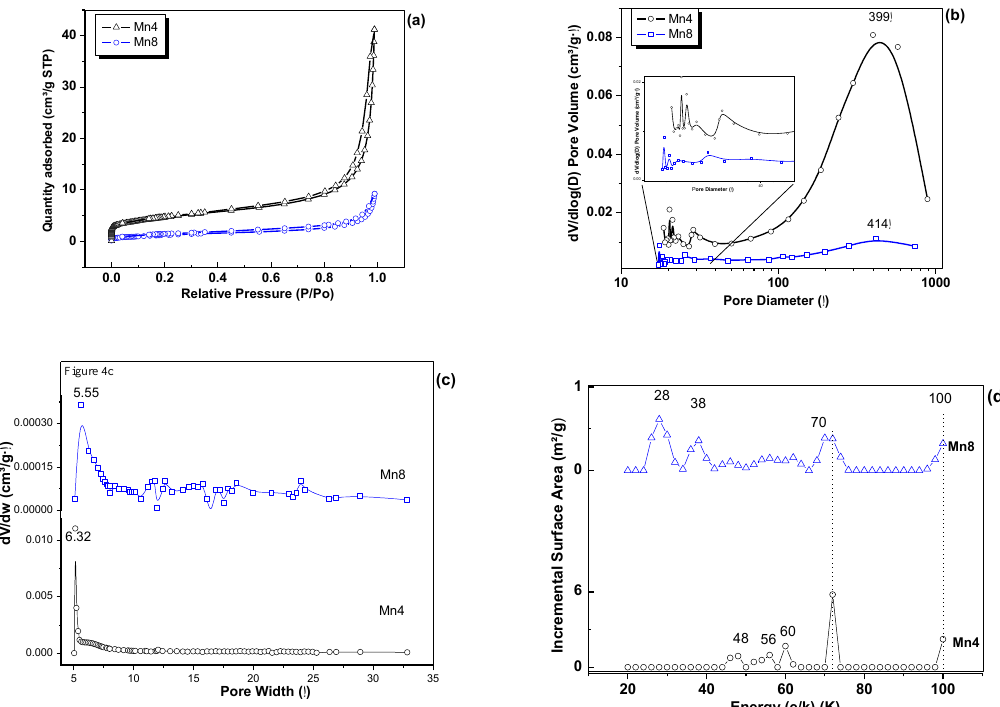
Figure 4. N 2 adsorption–desorption results: ( a ) N 2 isotherms, ( b ) mesopore size distribution by Barret–Joyner–Halenda (BJH), ( c ) micropore size distribution by Hovarth–Kawazoe (HK), and ( d ) interaction energy by nonlocal density functional theory